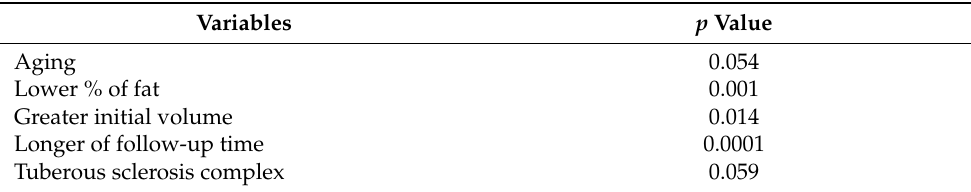
Table 3. Factors significantly associated with the decrease in tumor volume after selective arterial embolization. Variables p